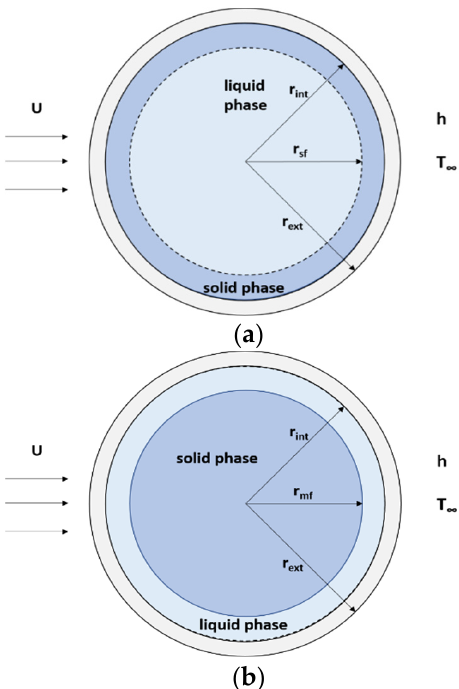
Figure 3. Schemes of the phase change processes within plastic spherical capsules: ( a ) solidification of PCM; ( b ) melting of PCM.